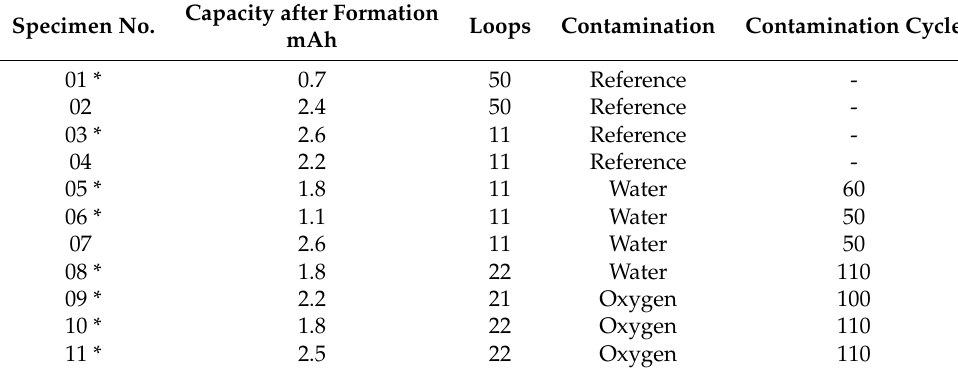
Table 2. Test matrix consisting of specimens with corresponding capacity after formation (10 cycles), contamination type and contamination cycle. Capacity after Formation Specimen No.